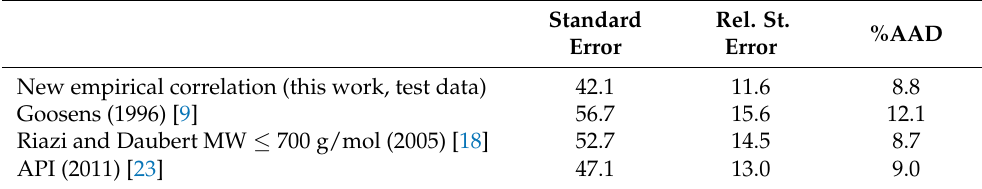
Table 4. Statistical analysis of the new empirical correlation developed in this work, and of the corre- lations of Goosens, Riazi and Daubert, and API with 124 data points not used in their development. Standard Rel. St. %AAD Error Error New empirical correlation (this work, test data) 42.1 11.6 8.8 Goosens (1996) [9] 56.7 15.6 12.1 Riazi and Daubert MW ≤ 700 g/mol (2005) [18] 52.7 14.5 8.7 API (2011) [23] 47.1